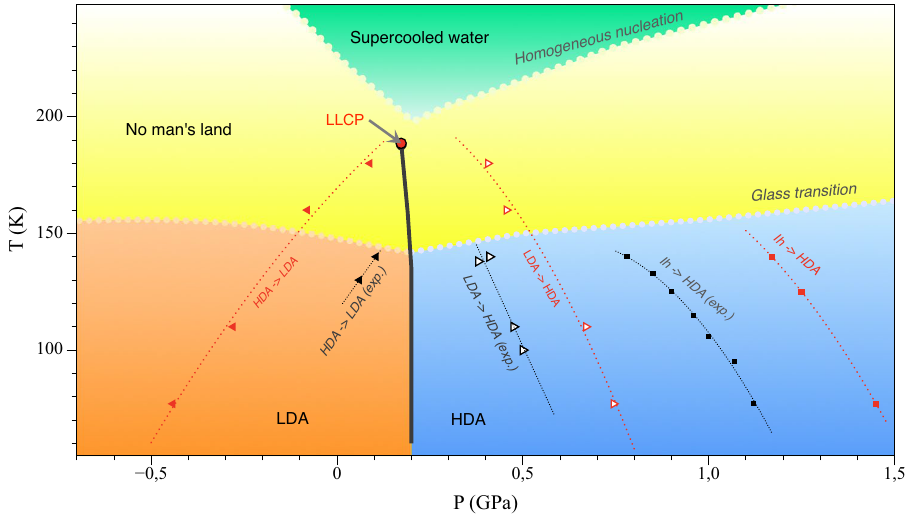
Figure 1. The T-P diagram of amorphous and liquid water. The separation line between a low density liquid and a high density liquid ends at the liquid–liquid critical point (LLCP) 17 . This point is located in an area called “no man’s land”, marked in yellow, where only crystalline forms of ice are experimentally observed. Transition lines based on the experiment 30 are indicated by black dotted lines; the lines based on the results of this work for the TIP4P/Ice model are in red dotted lines (the corresponding compression/decompression rate of 0.1